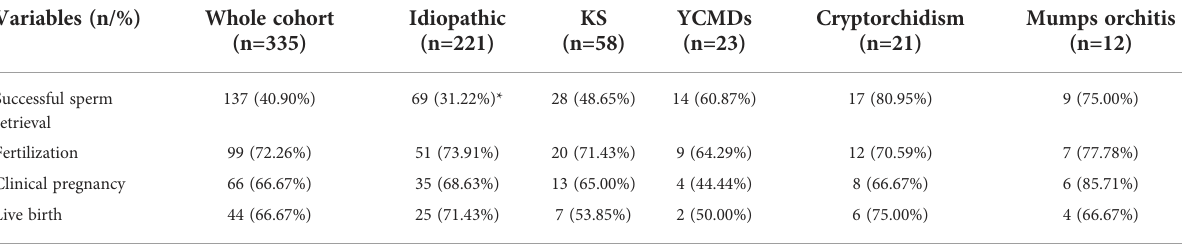
NOA, nonobstructive azoospermia; microTESE, microdissection testicular sperm extraction; ICSI, intracytoplasmic sperm injection; KS, klinefelter syndrome; YCMDs, Y chromosome microdeletions. The fertilization rate was referred to the number of patients with successful sperm retrieval. The clinical pregnancy was relative to the fertilization rate while the live birth was relative to the clinical pregnancy rate. * indicated signi fi cant differences between